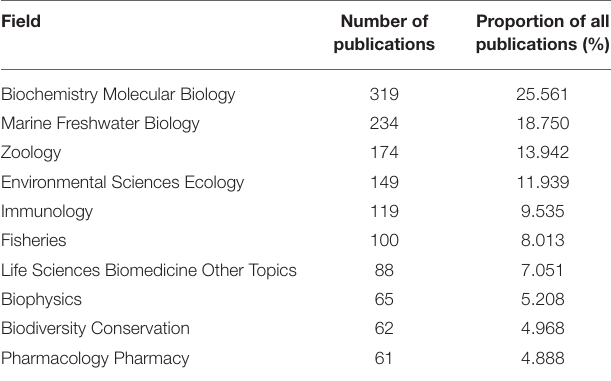
TABLE 6 | Numbers of publications and the proportion of all publications of the top 10 fields ranked by the number of publications based on WOS.